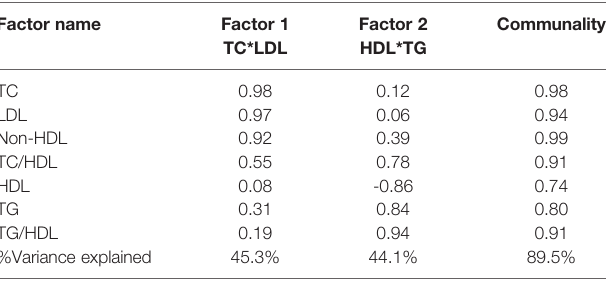
TABLE 3 | Factor analysis of individual lipid parameters and ratios